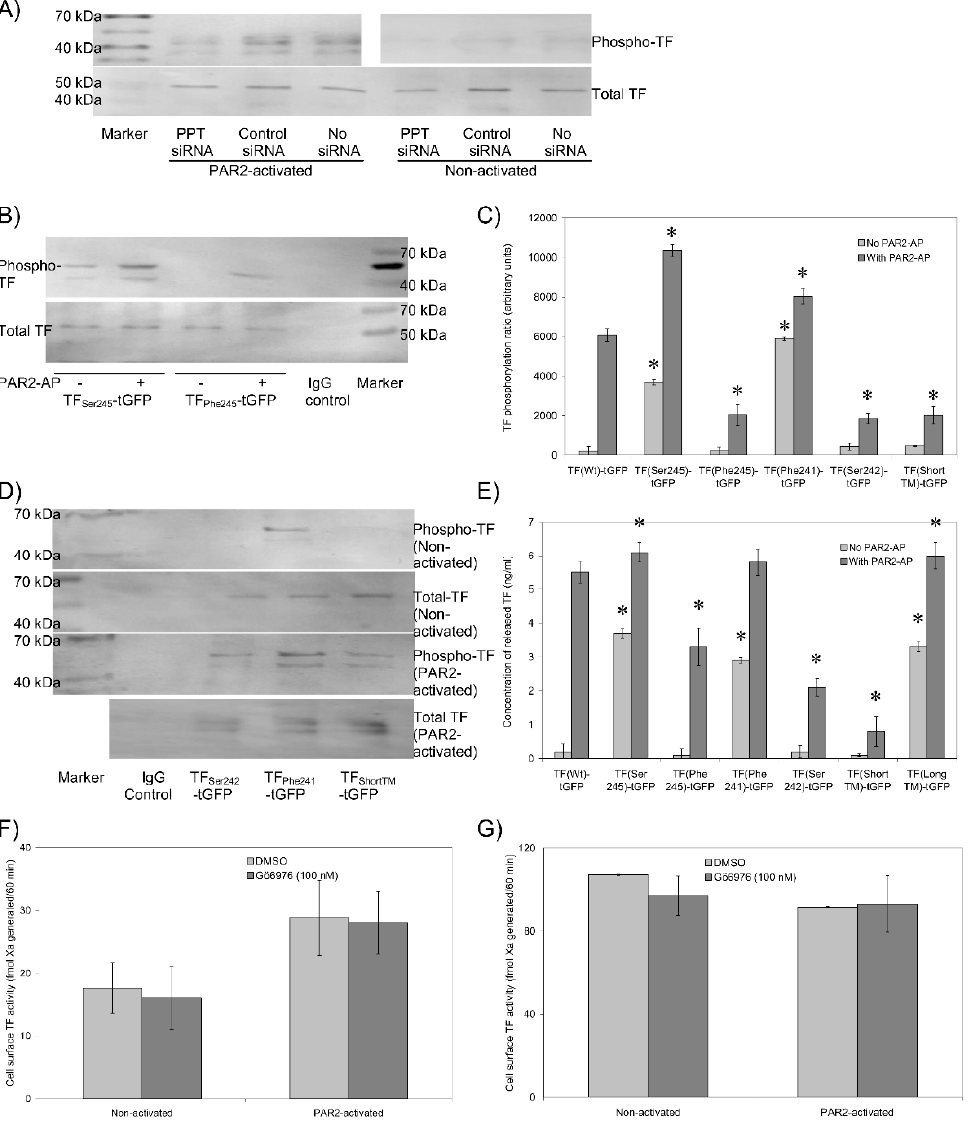
Figure 5. Analysis of Ser253 phosphorylation in the TF variants. HDBEC (2 × 10 5 ) were transfected ( A ) to express TF Wt -tGFP in the presence and absence of PPT-siRNA or ( B ) to express TF Ser245 -tGFP or TF Phe245 -tGFP. Cells were activated with PAR2- AP (20 µ M) for 20 min, and TF-tGFP was then immunoprecipitated and analysed by western blot and ( C ) the phosphorylation of Ser253 was quantified. ( n = 3, * = p < 0.05 vs. the respective cells expressing TF Wt -tGFP.) ( D ) HDBEC (2 × 10 5 ) were transfected to express TF Phe241 -tGFP, TF Ser242 -tGFP, TF ShortTM -tGFP or TF Val225 -tGFP, and the phosphorylation of Ser253